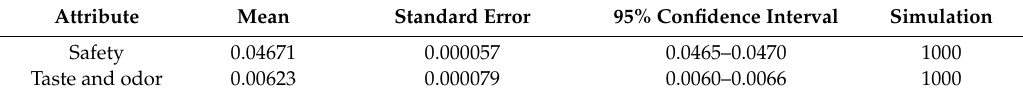
Table A4. Confidence interval of the median WTPs by using